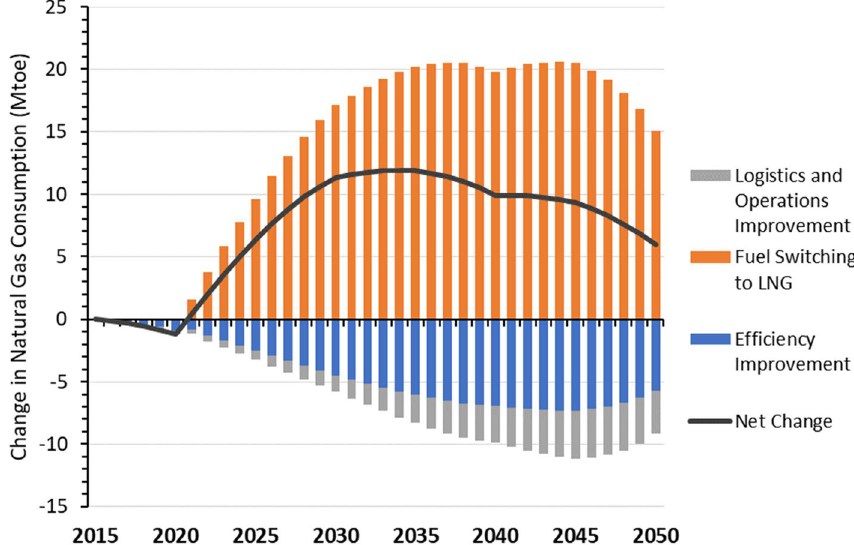
Figure 4. Impact of short-term strategies on heavy-duty truck natural gas consumption.